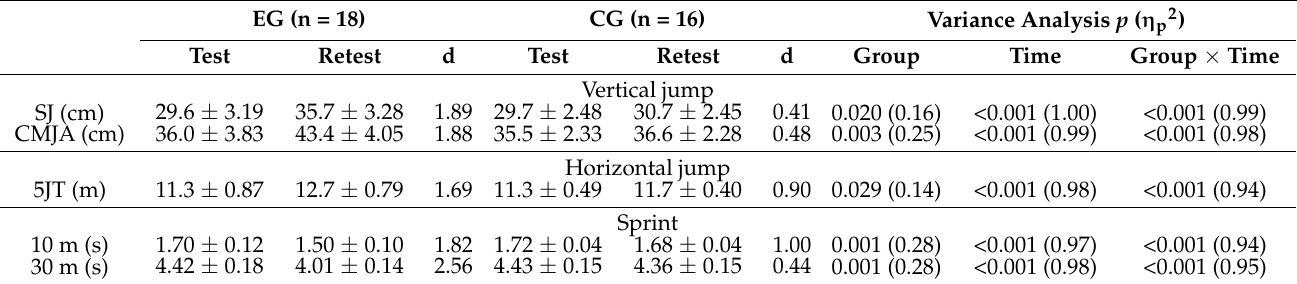
Table 4. Jump and sprint test performances depending on groups (EG vs. CG) before and after 8-week intervention. Meaningful effects (criteria: p < 0.05 and η p2 > 0.15 and d > 0.80) are highlighted in